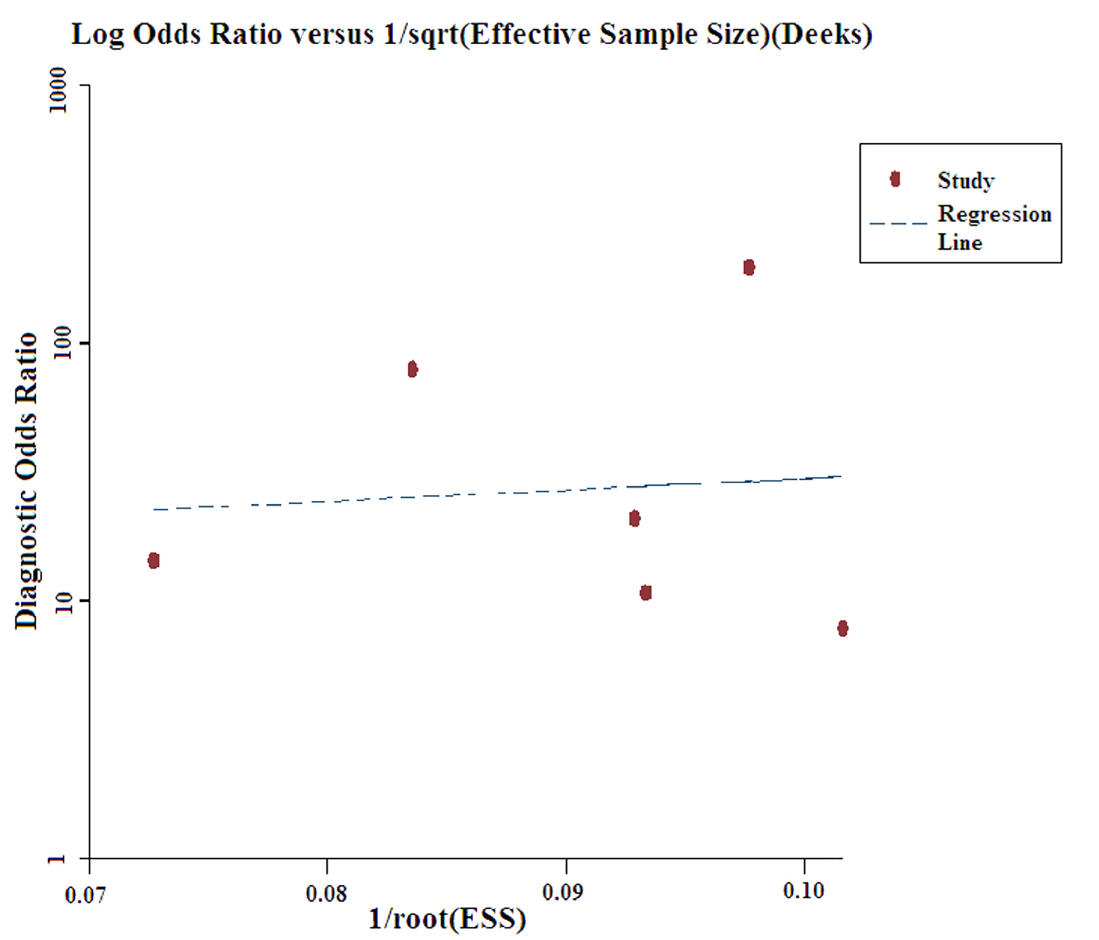
Fig 4. Funnel plot for the assessment of potential publication bias in miR-21